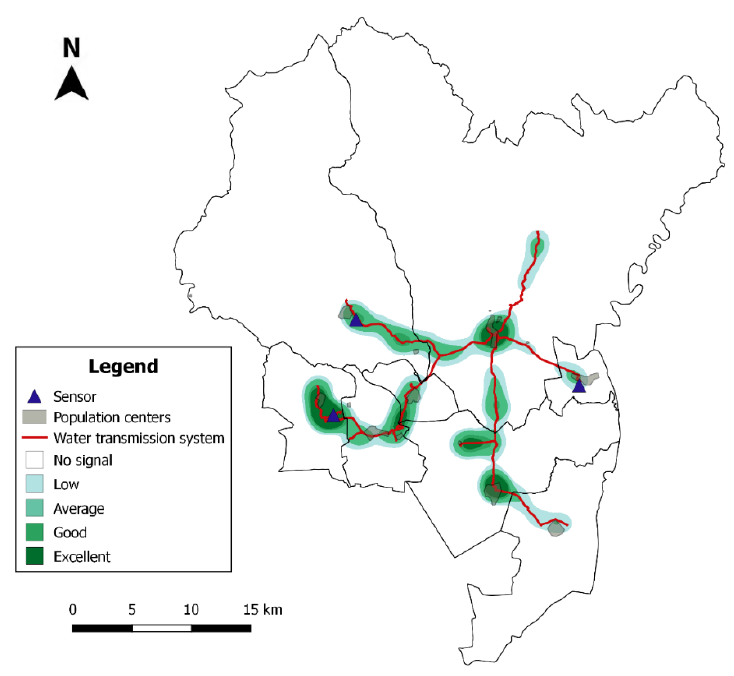
Figure 11. Distribution of Sigfox coverage intensity over the water distribution network. Figure 11 divides the signal quality into five categories: no signal, low, average, good and